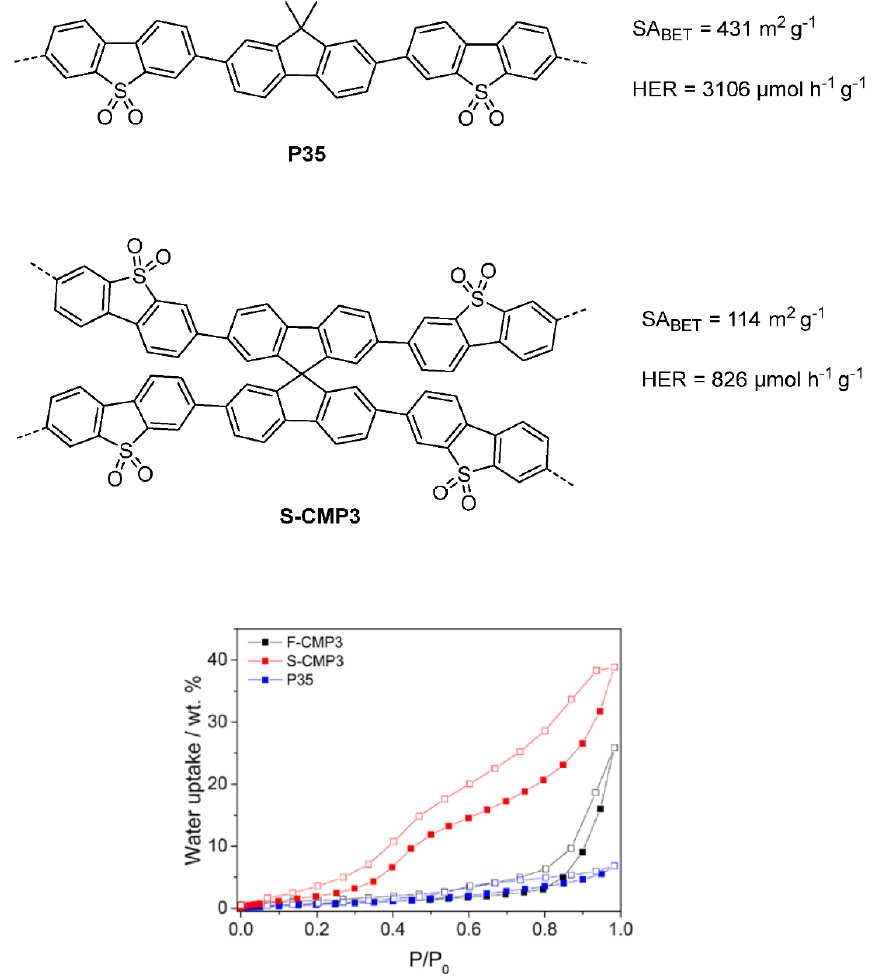
Figure 28. Top: Linear and microporous conjugated polymers with their corresponding BET surface areas and hydrogen evolution rates. Bottom: Water uptake measurements performed at 20 °C for S-CMP3, F-CMP3, and P35, respectively. Solid squares indicate adsorption whilst open squares indicate desorption [Figure from ref. [37] under CC-BY License].